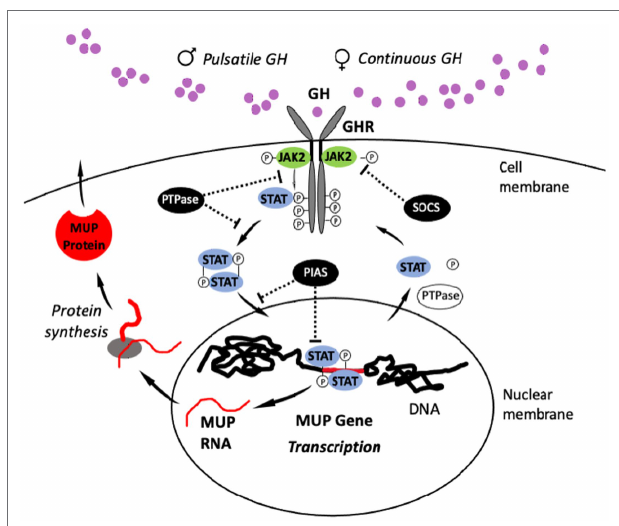
FIGURE 6 | JAK2-STAT5 Signaling Pathway. The pulsatile pattern of GH release in male mice activates the JAK2-STAT5 signaling pathway (or “signaling cascade”): Circulating GH binds to transmembrane GH receptors (GHR), which are members of the cytokine receptor family and widely expressed on the surface of target cells in the liver. GH binding induces a conformational change in GHRs that activate Janus kinase 2 (JAK2), and then this enzyme phosphorylates the cytoplasmic domain of the GHR, generating docking sites for the transcription factor STAT5b. After STAT5b binds to these sites, it undergoes JAK2-catalyzed tyrosine phosphorylation and dissociates from the GHR to form homodimers (e.g., STAT5-STAT5) or heterodimers with other STAT proteins. STAT5 dimers enter the nucleus and bind response elements in gene regulatory regions, initiating transcription (Udy et al., 1997; Teglund et al., 1998). After transcription, STAT5b is deactivated by phosphotyrosine phosphatase (PTPase). STAT5b can then enter into another cycle of JAK2-catalyzed phosphorylation, and it can undergo multiple rounds of this cycle in response to a single male GH pulse (Gebert et al., 1999).